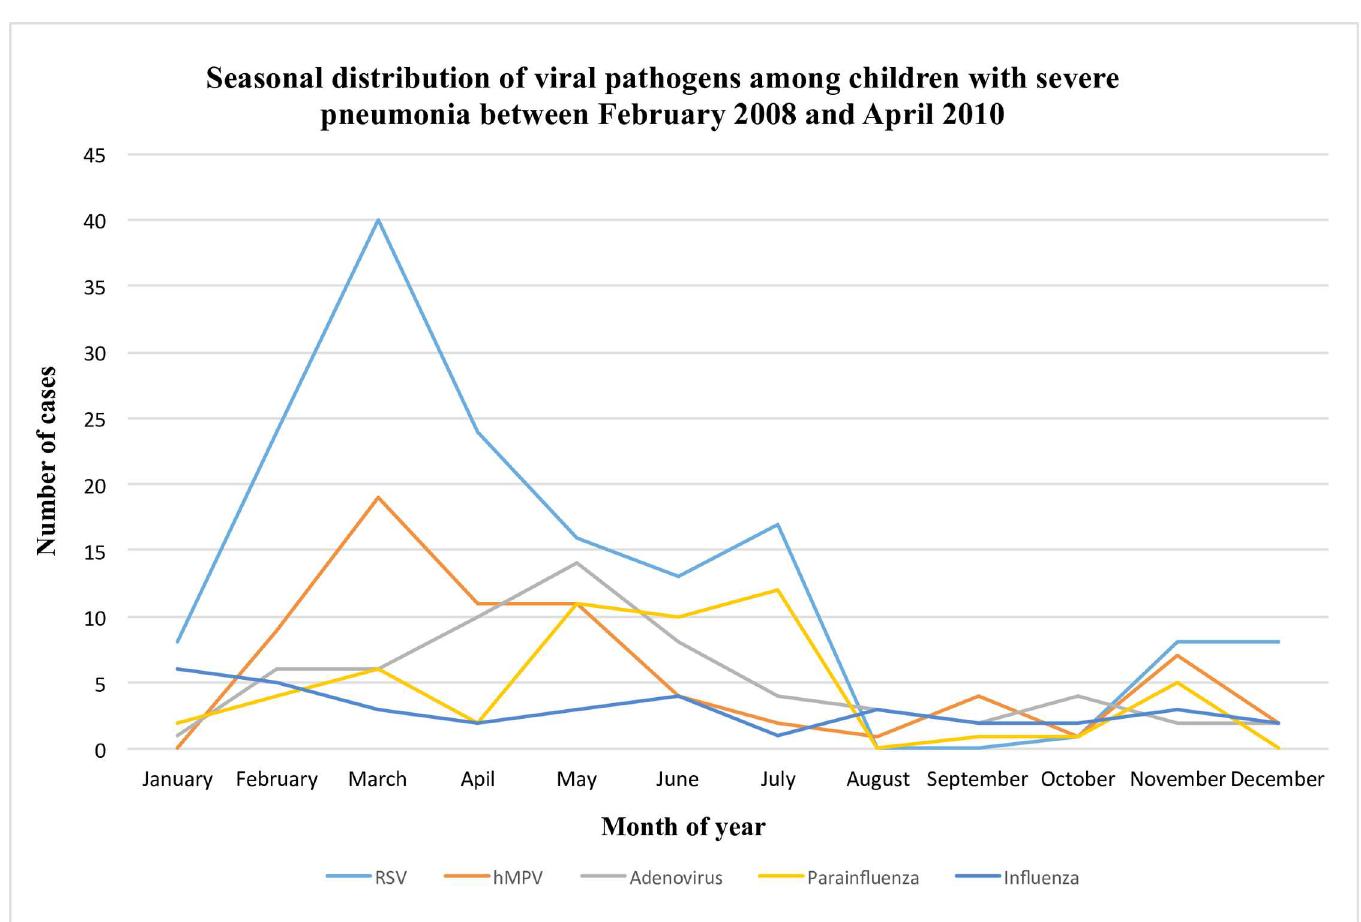
Fig 2. Seasonal distribution of viral pathogens among children with severepneumonia between February 2008and April